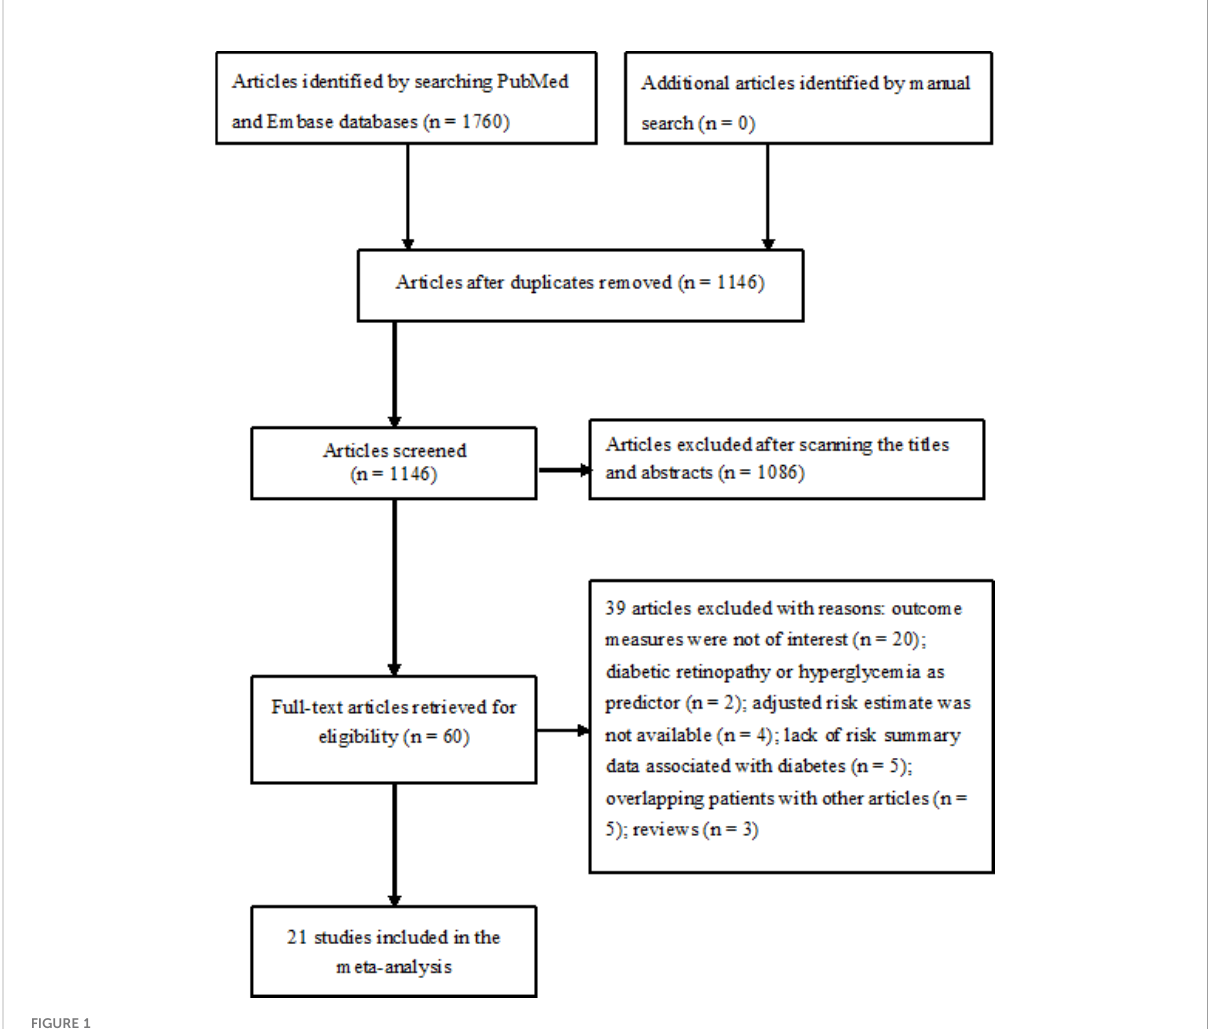
FIGURE 1 Flowchart showing the process of study